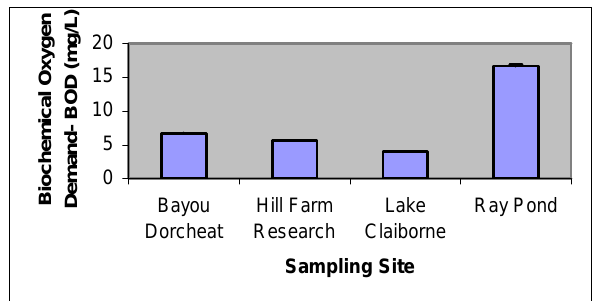
Figure 2: Mean values of biochemical oxygen demand BOD (mg/L) at each sample site (n=15).